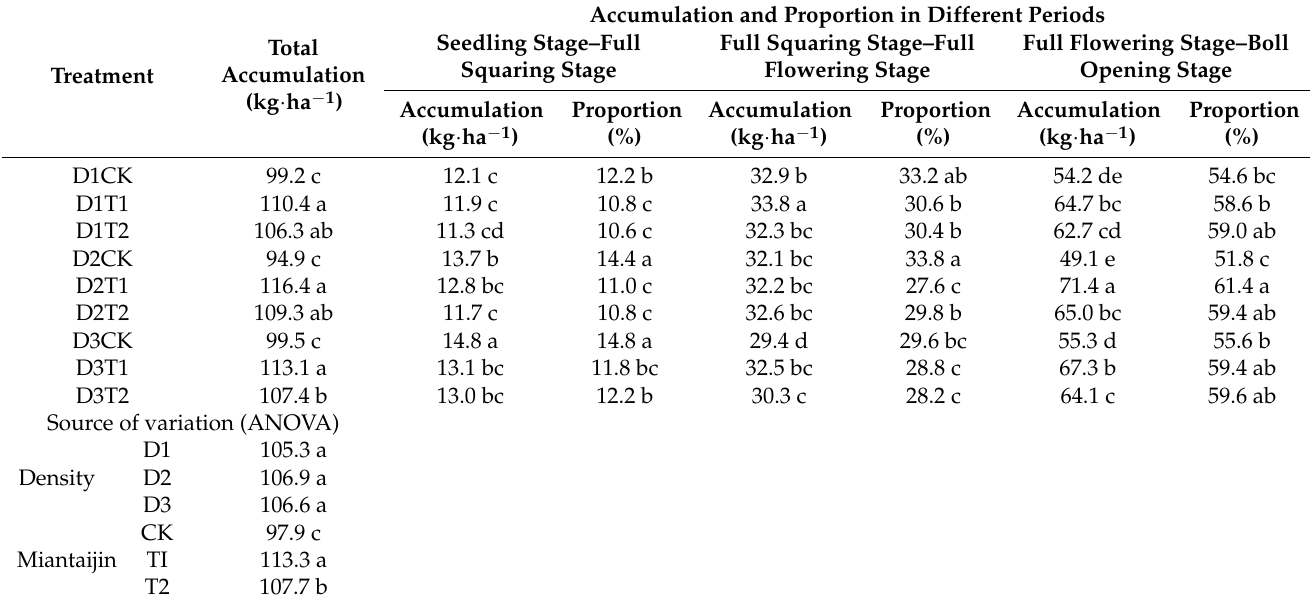
Table 5. Effects of density and Miantaijin on K accumulations (2018).